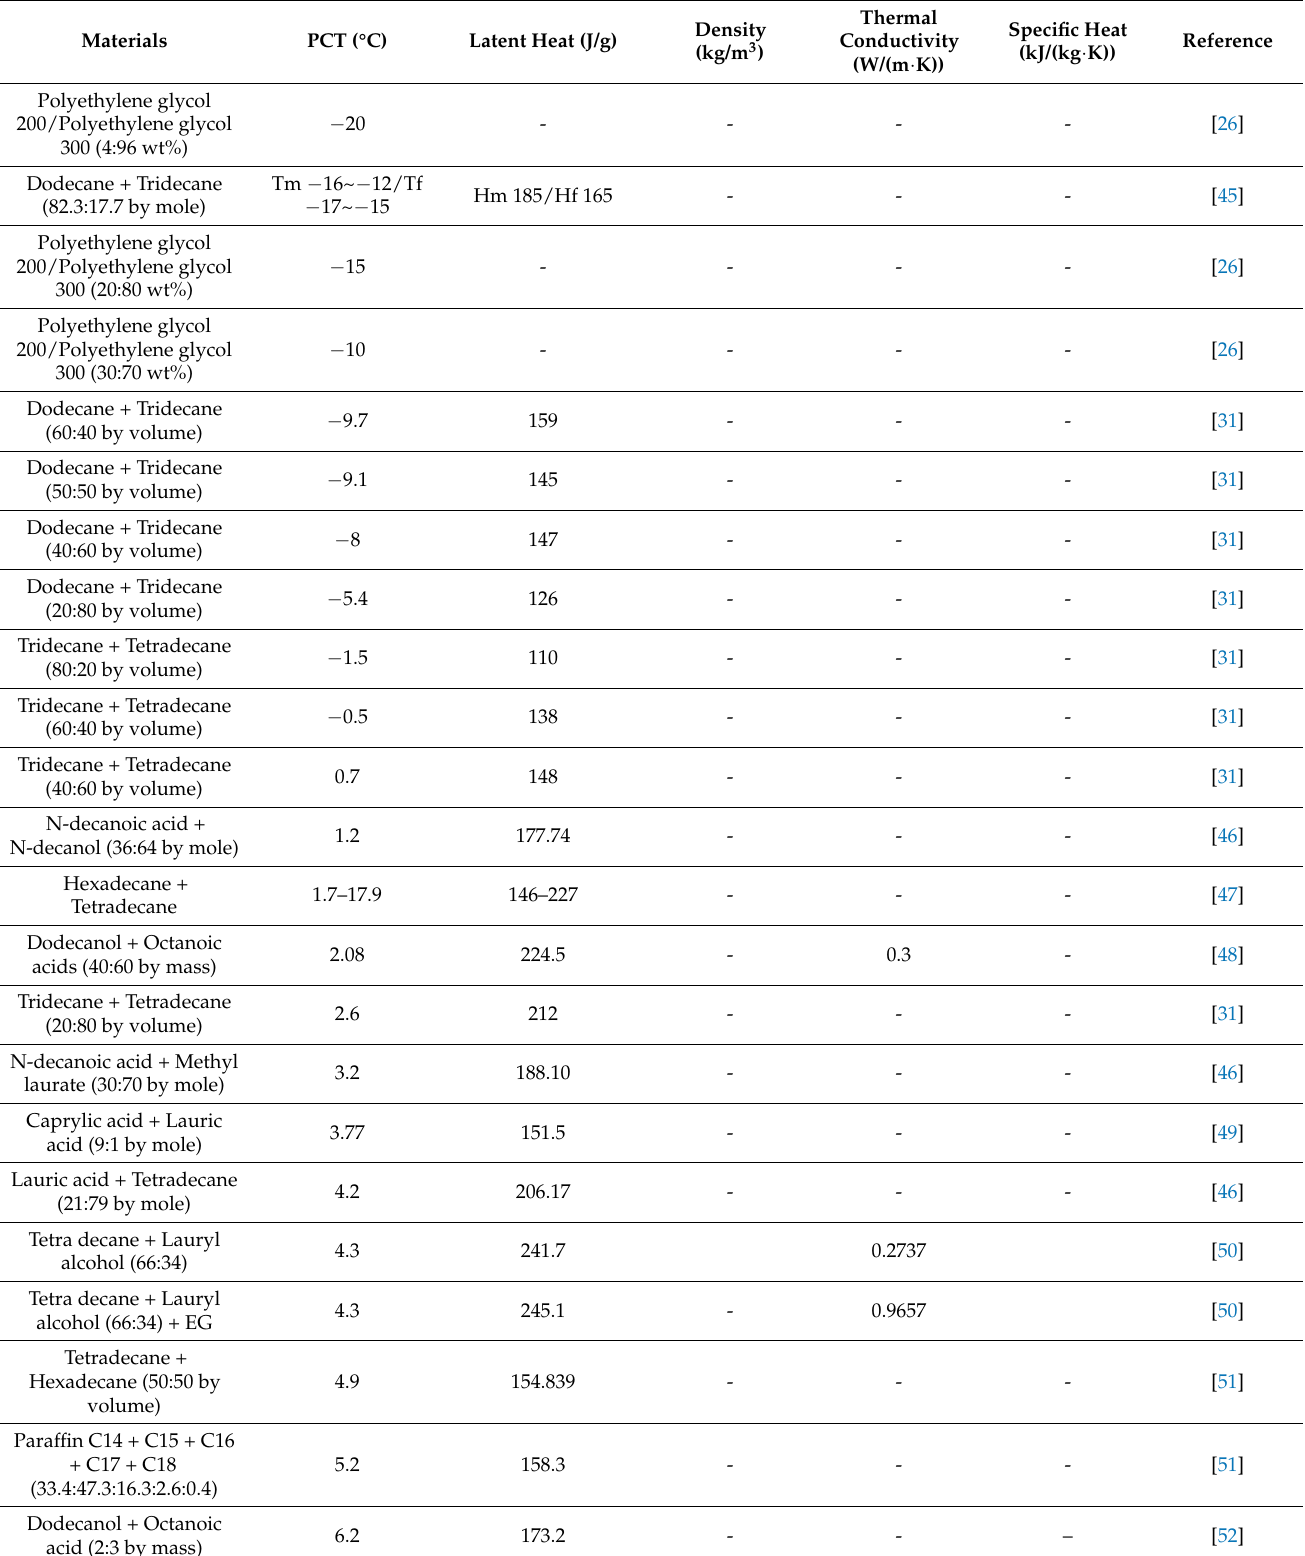
Table 3. Typical organic eutectic PCMs for